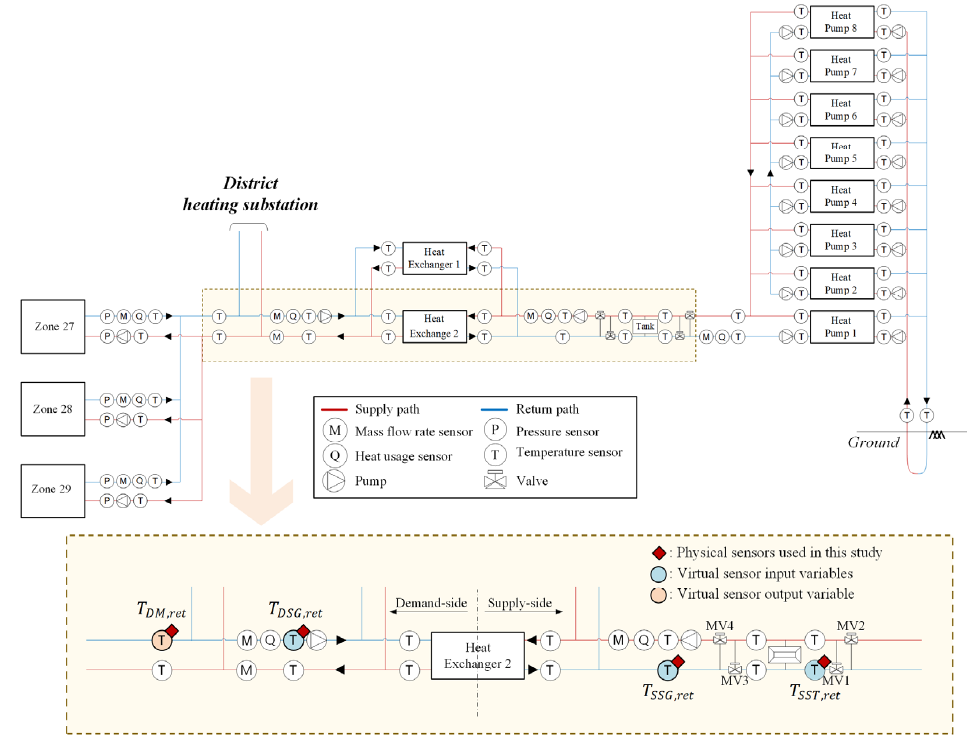
Figure 1. Diagram of the target heating system. Table 1. Equipment specification of a geothermal storage system in the winter.